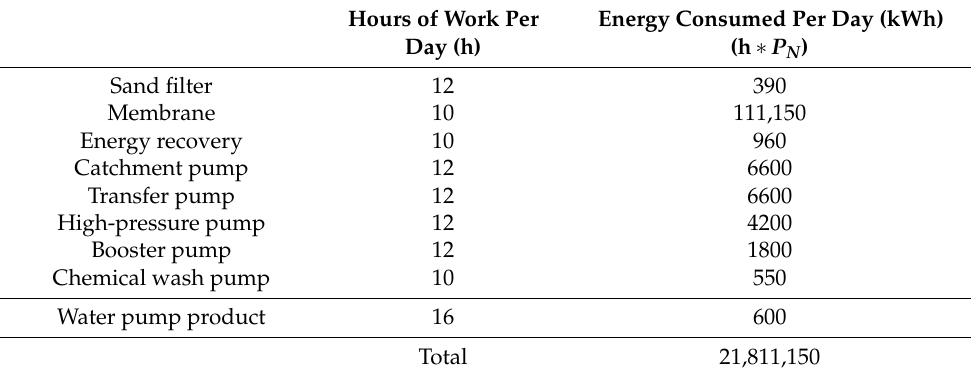
Table 11. Energy consumed per day for each element.